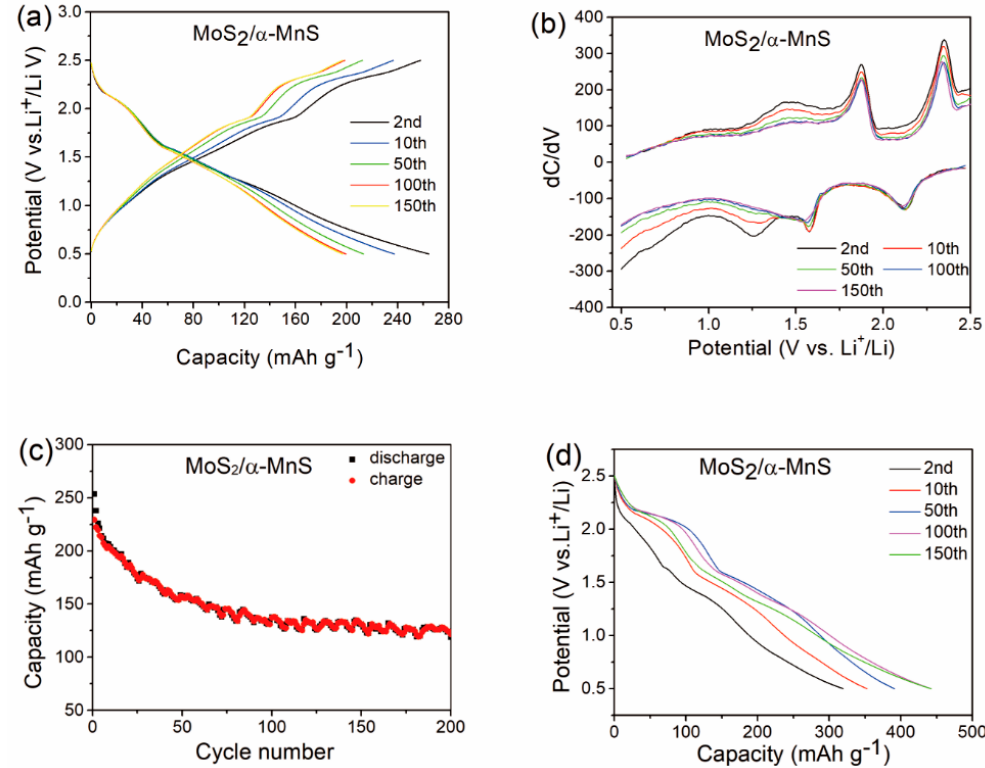
Figure 4. The galvanostatic measurements tested in the voltage range of 0.5 − 2.5 V for hierarchical MoS 2 / α − MnS nanocomposites. ( a ) Discharge − charge profiles at 200 mA g − 1 . ( b ) The corresponding derivative relation of the galvanostatic voltage versus the capacity. ( c ) Cycling performance profiles at 200 mA g − 1 . ( d ) Discharge capacity versus voltage curves of Figure 3a within 0.5 − 2.5 V.